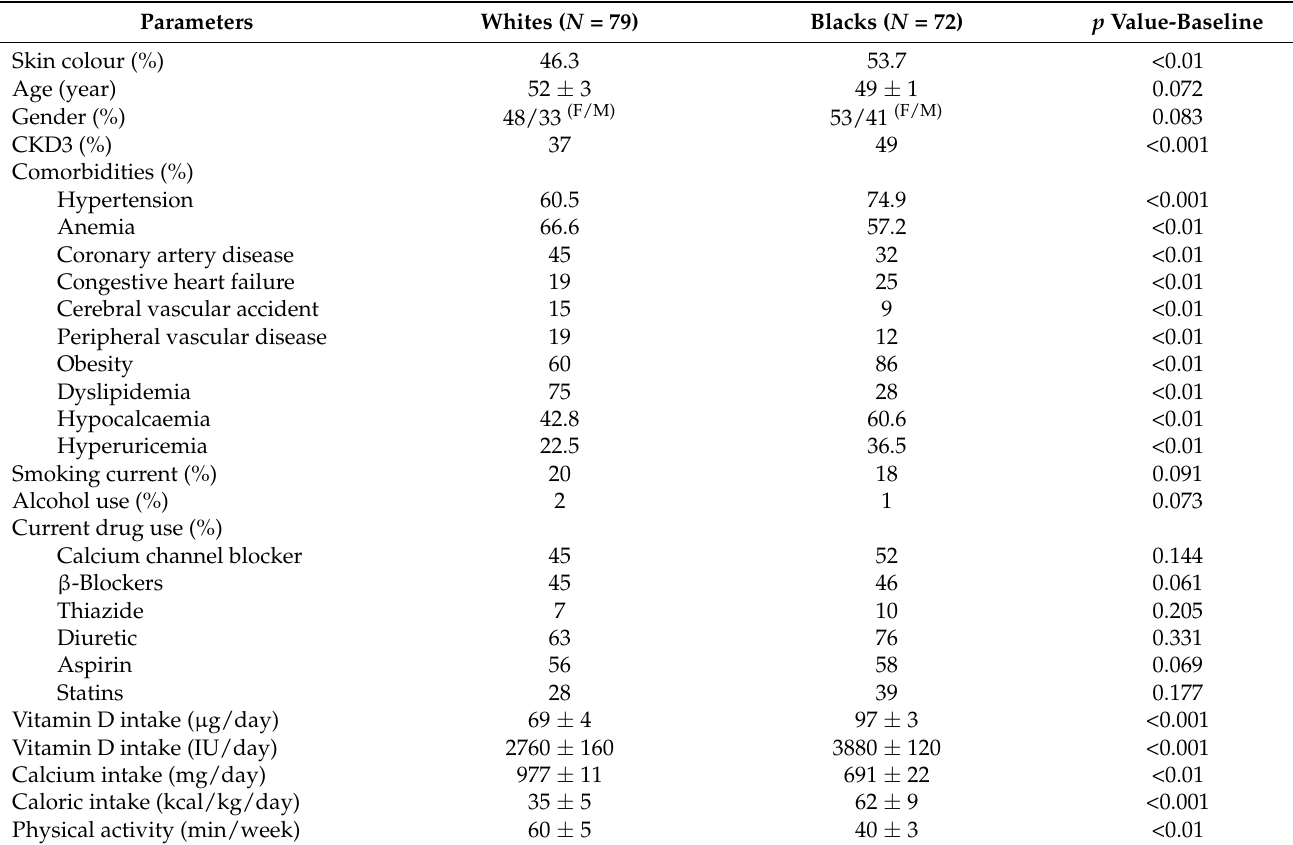
Table 1. Baseline Clinical characteristics in Blacks versus Whites in SS general